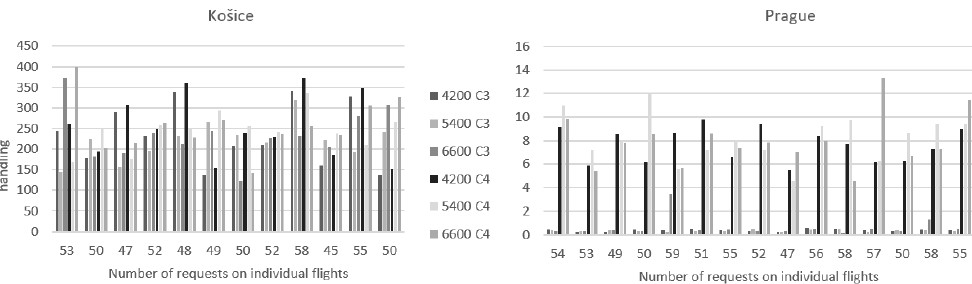
Figure 9. The average waiting time in the queue/for handling when the handling time is changed. For Prague flights, the difference between the C3 and C4 criteria is more visible. In